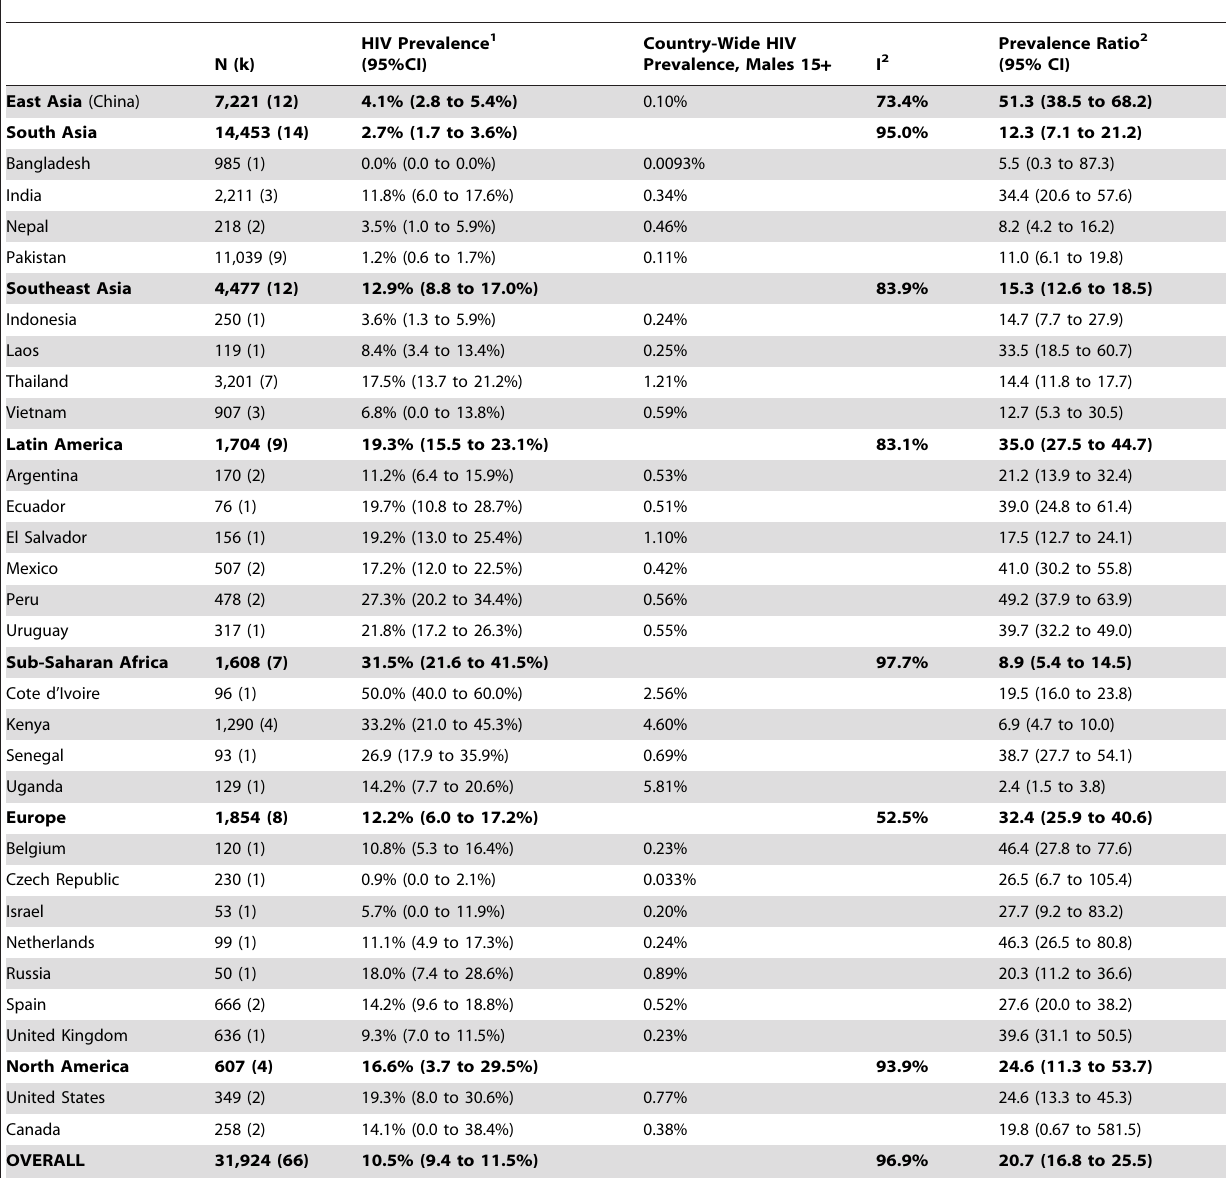
Table 3. Prevalence ratios comparing pooled HIV prevalence among men who engage in transactional sex to general population men aged 15 and